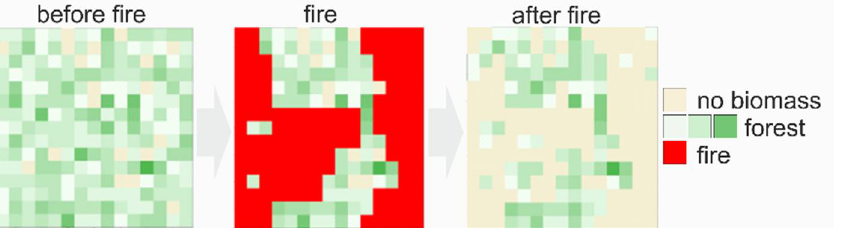
Figure 8. The heterogeneity of biomass in a virtual landscape before the simulated fire (left), during